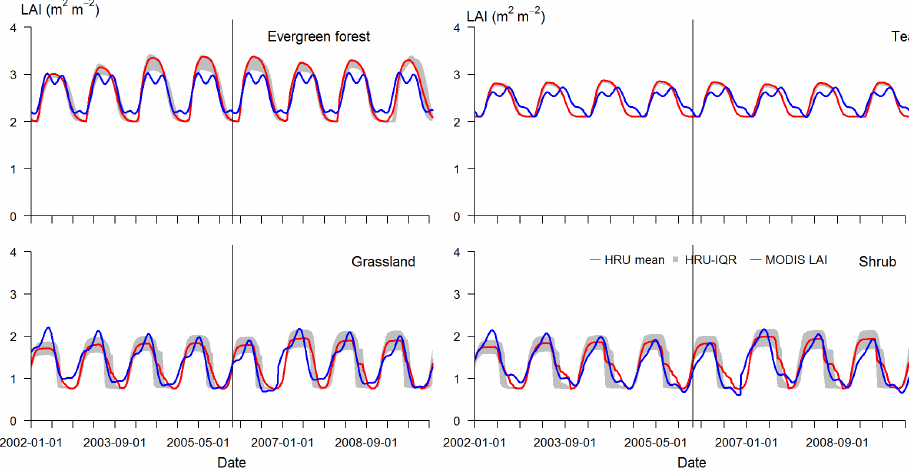
Figure 7. The MODIS LAI and the SWAT-T model-simulated, HRU-weighted, aggregated 8-day LAI time series (2002–2009). The grey shading indicate the boundaries of the 25th and 75th percentiles. The vertical line marks the end of the calibration period and the beginning of the validation